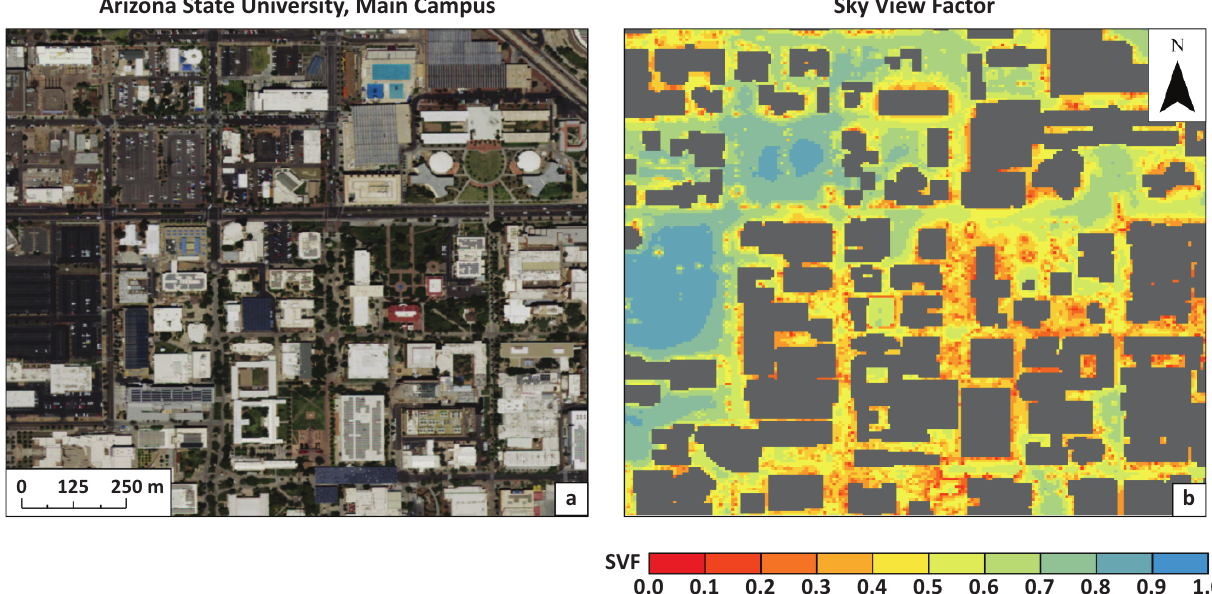
Figure 5. Aerial photo (a) and high-resolution Sky View Factor map at 1.1 m height (b) for the north-west corner of Arizona State University’s Tempe